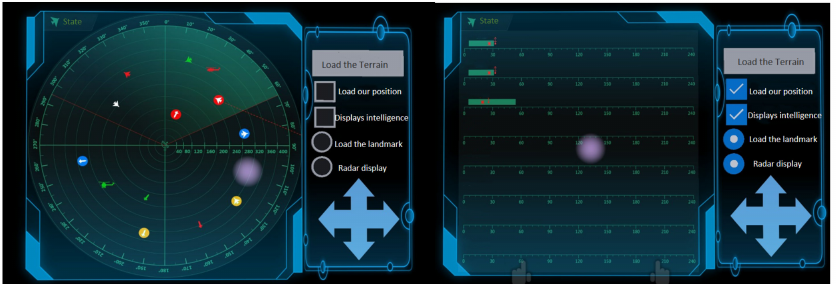
Figure 9. Select interface display content.